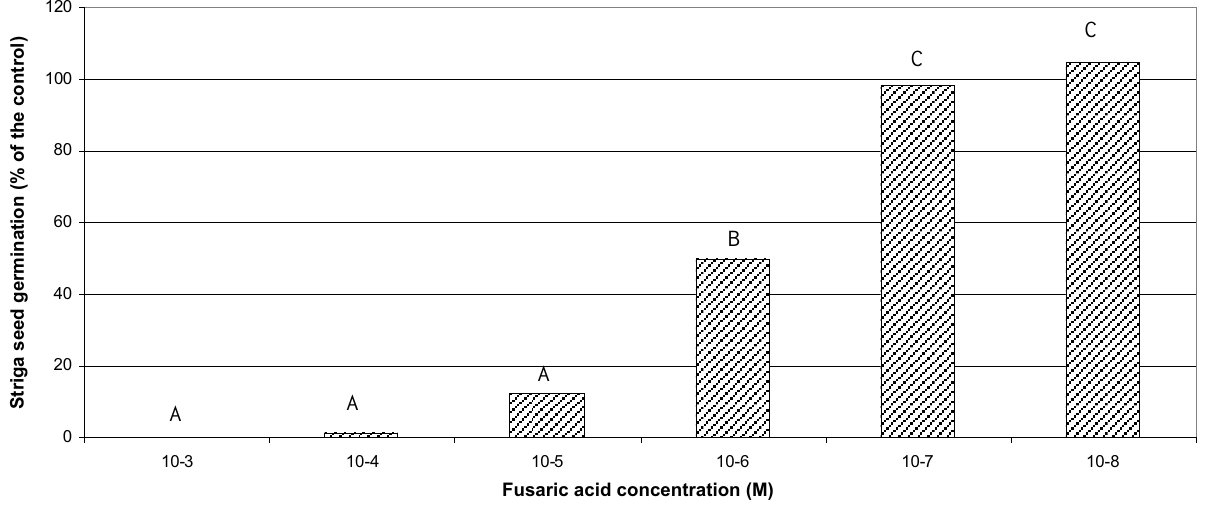
Fig. 2. Effect of fusaric acid on Striga hermonthica seed